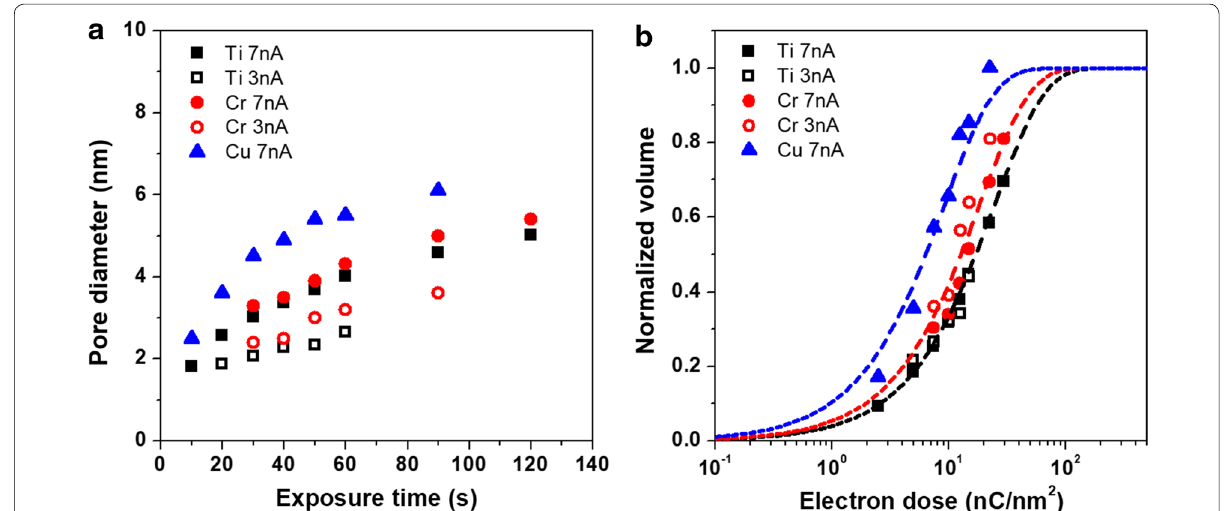
Fig. 3 a Pore diameters of Ti, Cr, and Cu membranes as a function of e‑beam exposure time and b contrast curve of nanopore